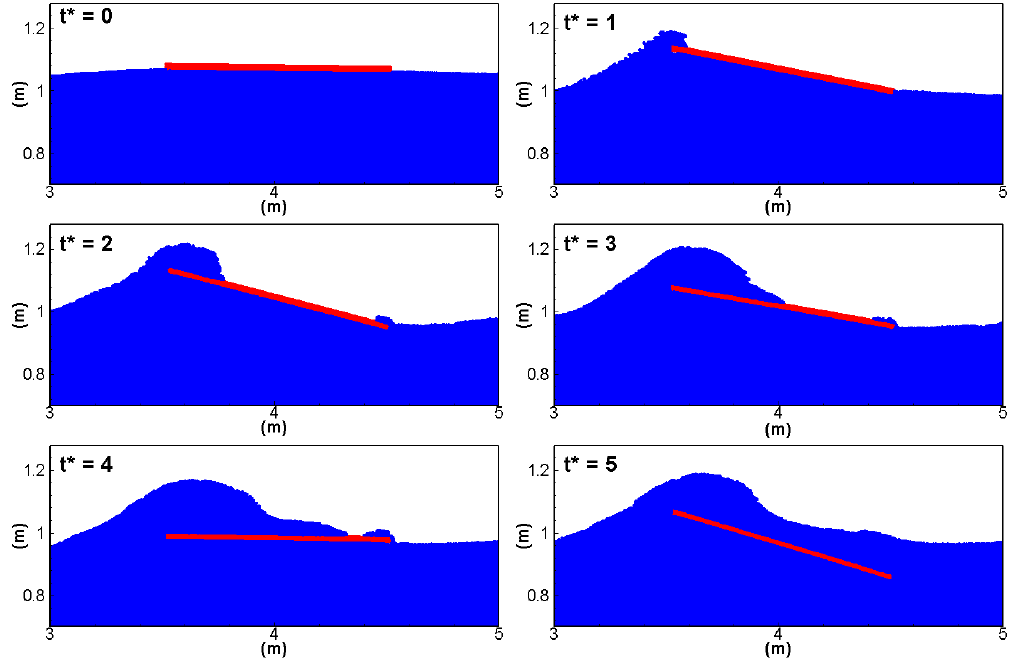
Figure 9. Dynamics of the floating plate with Young modulus E = 2.5 GPa under severe wave conditions with wave steepness ka = 0.5. Ratio of the plate length to the wavelength is 2 L / λ =